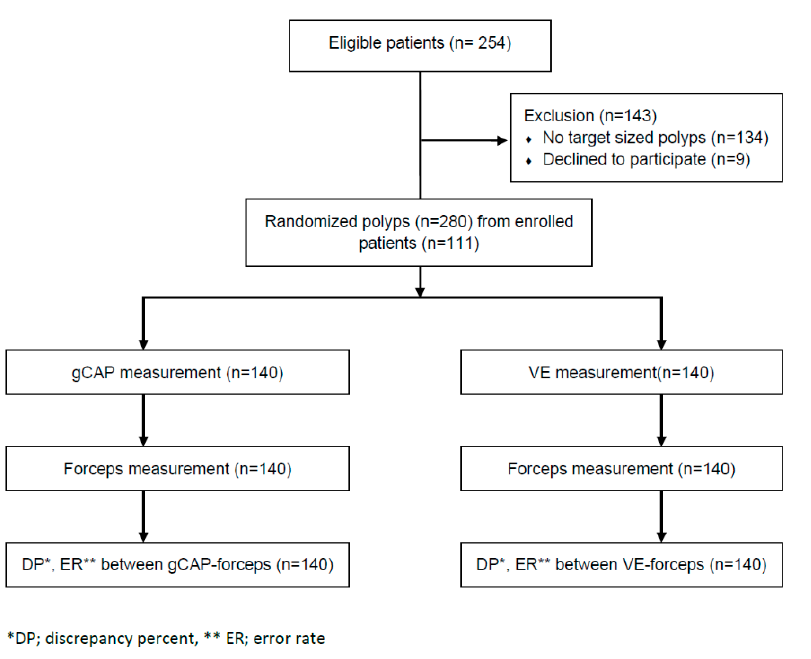
Figure 3. Study process flowsheet. The mean age of the enrolled patients was 64 years (gCAP vs. VE: 63.7 ± 85 years vs. 63.8 ± 10.9 years, p = 0.971), and the ratio of men to women was higher in the gCAP group than in the VE group (71.4% vs. 50.9%, p = 0.027). No differences in the ratio of expert endoscopists, history of abdominal surgery, bowel preparation, cecal intubation time, polyp withdrawal time, and number of detected polyps between the groups were